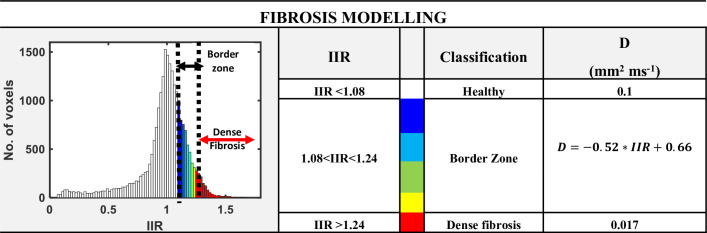
Segmentation and modelling of fibrosis.Labelling of voxels in the LA patient geometries according to their LGE MRI intensity ratio (IIR) relative to the blood pool. Voxels with IIR>1.24 are considered to be part of a fibrotic core. IIR<1.08 corresponds to healthy tissue and the intermediate values of IIR form a fibrotic border zone with intermediate properties.